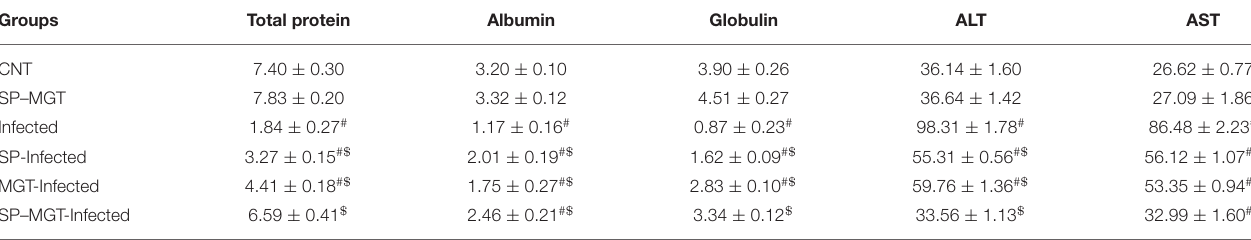
TABLE 1 | Serum liver biomarkers in response to co-treatment with Spirulina platensis and/or matcha green tea in S. mansoni infected mice.